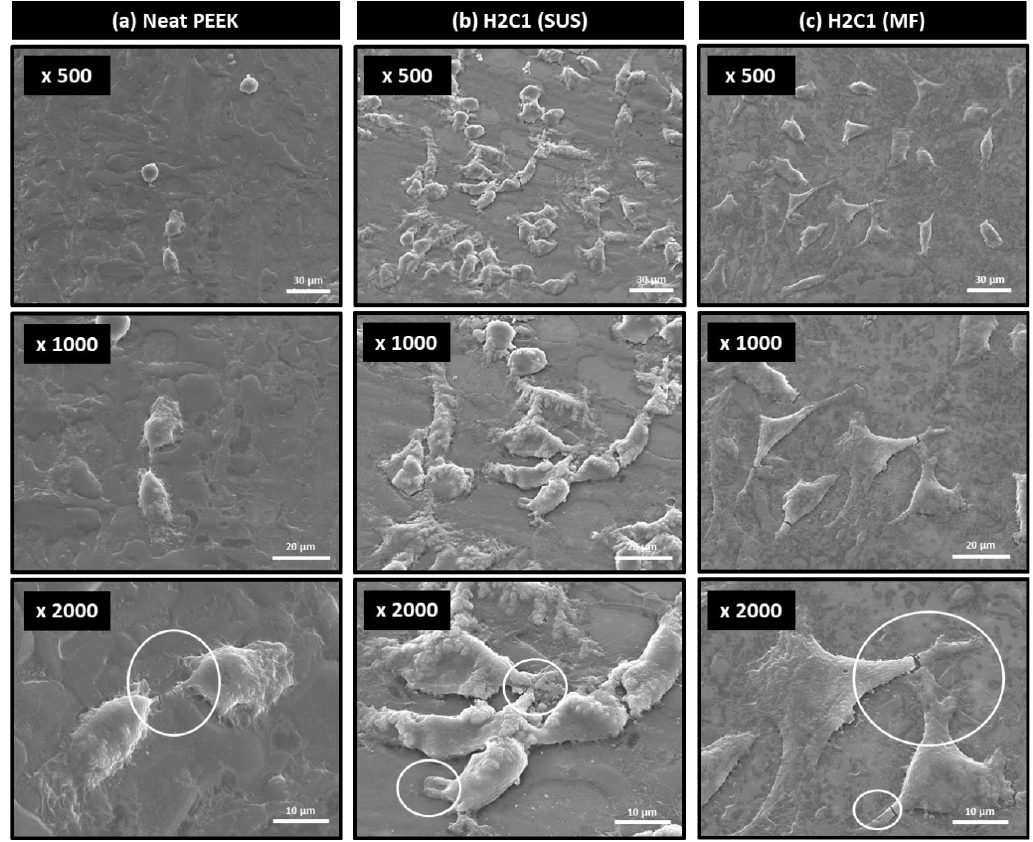
Figure 7. SEM images of cell morphologies on the PEEK substrates; ( a ) neat PEEK, ( b ) H2C1 (SUS), ( c ) H2C1 (MF).